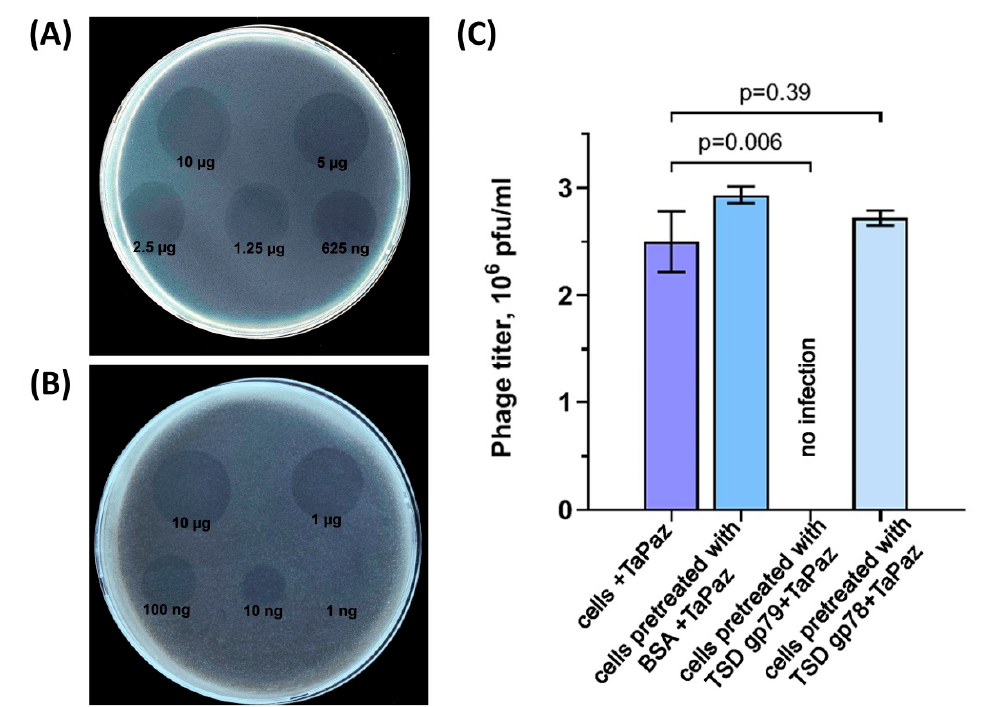
Figure 5. Spot tests with serial 2-fold ( A ) and 10-fold ( B ) titration of purified recombinant depolymerase TaPaz_gp79 on A. baumannii NIPH601 lawn after 12 h of incubation. ( C ) Phage TaPaz infection inhibition by TSD TaPaz_gp79. From left to right, phage titers observed on the bacterial lawns after the treatment of A. baumannii NIPH601 cells with phage TaPaz only, after cell cultures preincubated with BSA (as a negative control), purified specific TSD TaPaz_gp79 and purified not specific TaPaz_gp78 (as a negative control) followed by phage TaPaz treatment.